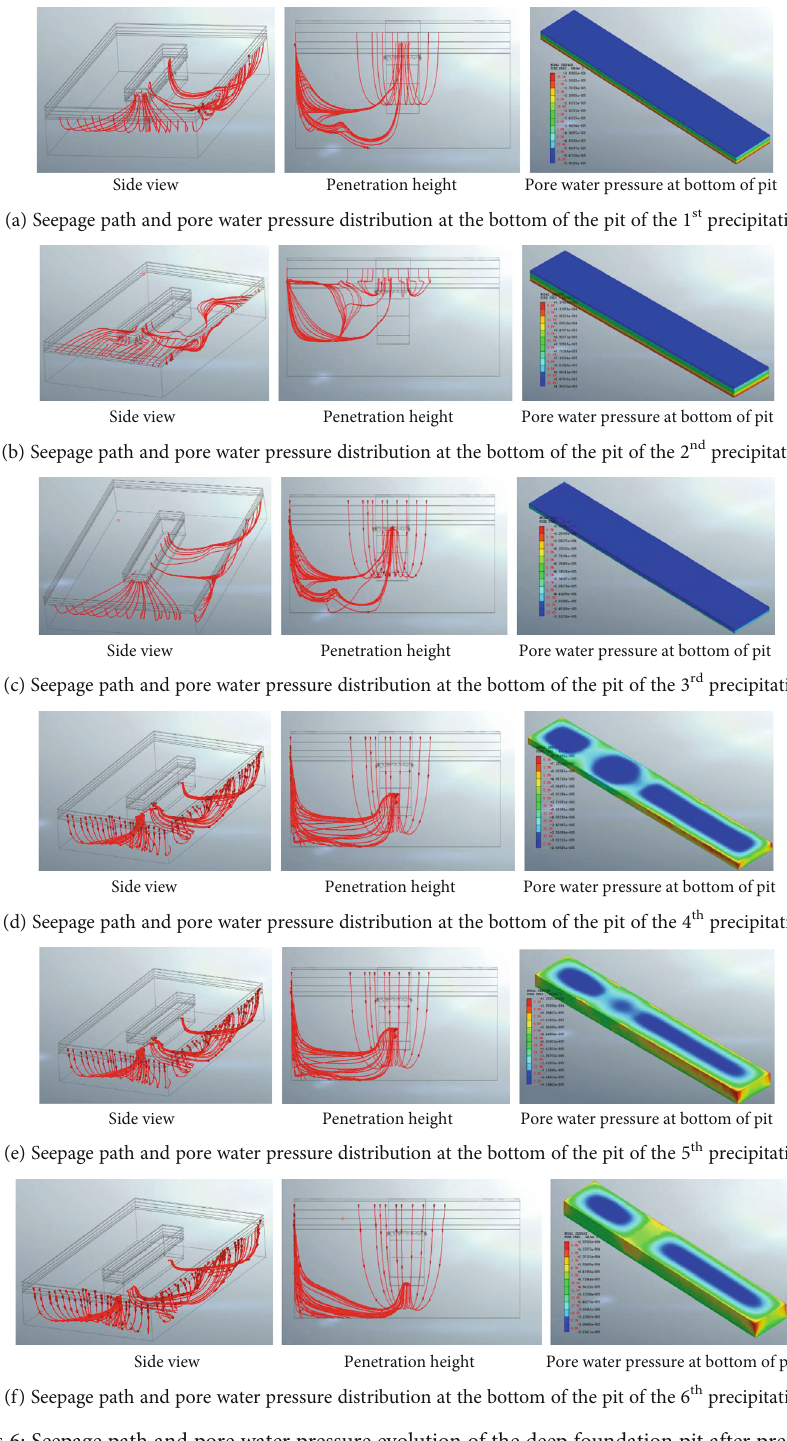
Figure 6: Seepage path and pore water pressure evolution of the deep foundation pit after